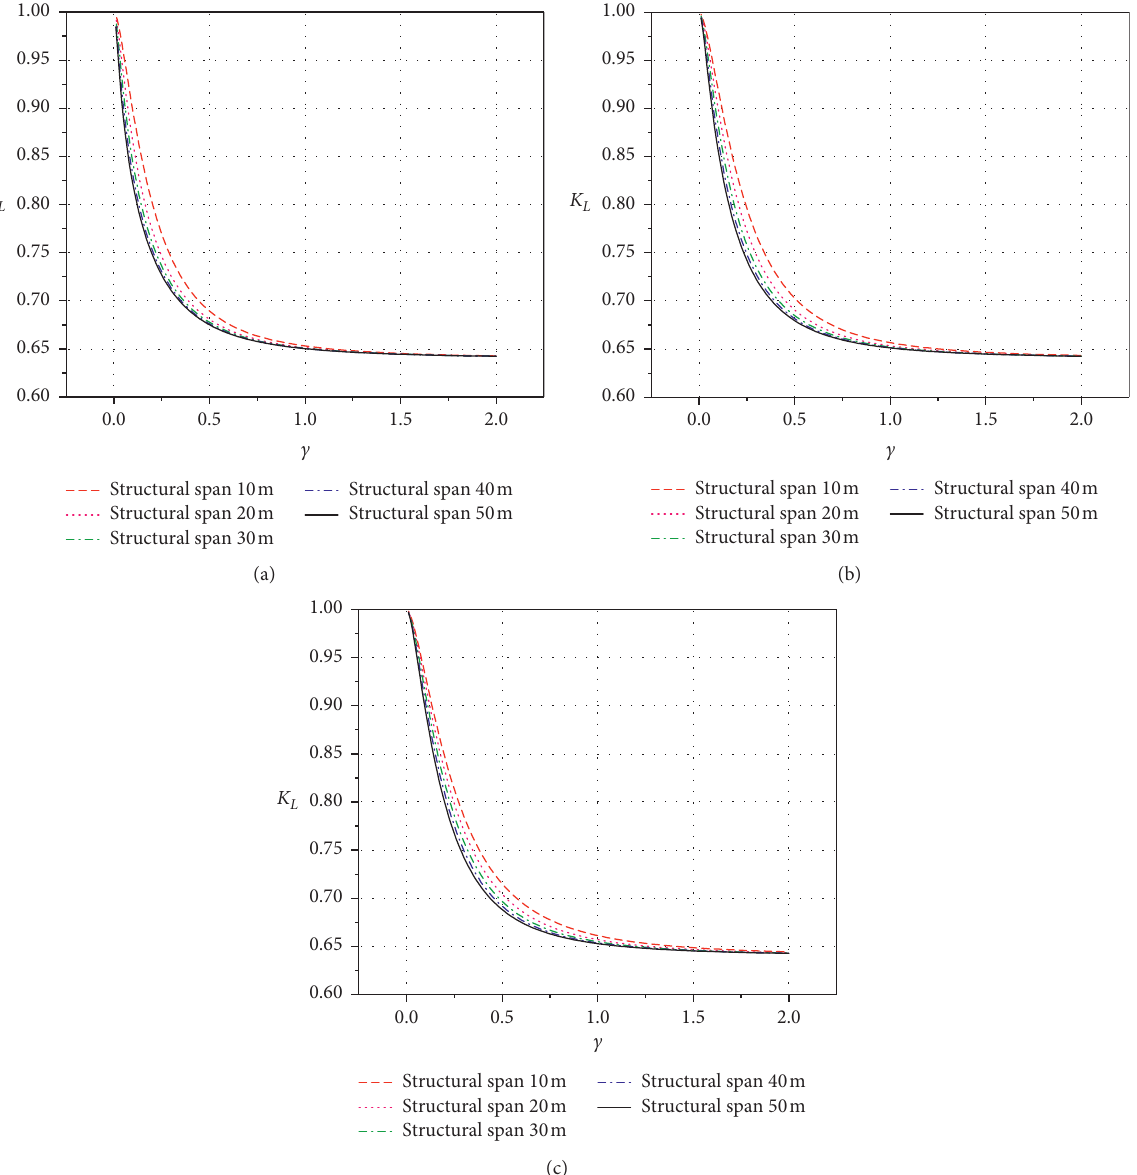
Figure 2: Equivalent load transformation factors of simply supported one-way members using Mills’ formula parameters: (a) W � 1kg. (b) W � 10 kg. (c) W �